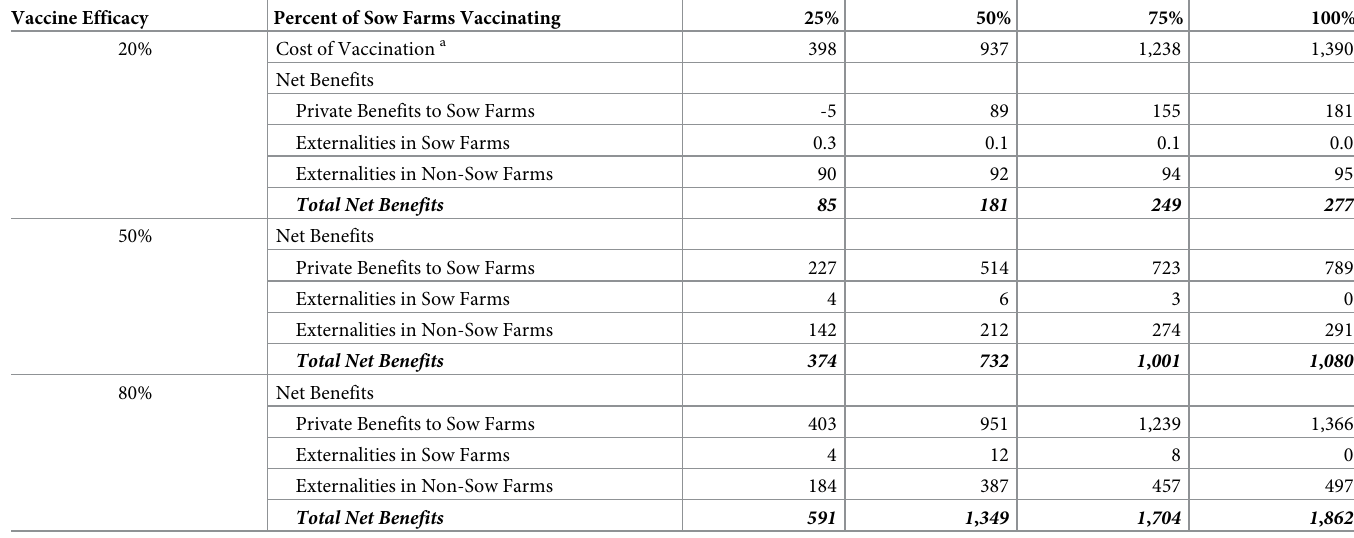
Table 5. Private, social, and total net benefits ( US$ Thousands ) from vaccination as sow farm vaccination increases if the expected virus is of average virulence. Vaccine Efficacy Percent of Sow Farms